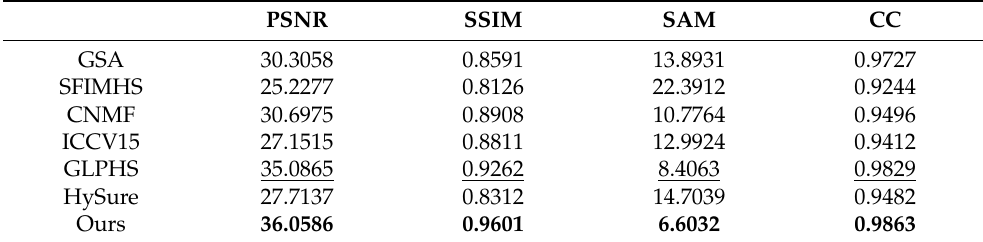
Figure 8. Results of CAVE dataset with real multispectral images. ( a ) results of GSA; ( b ) results of SFIMHS; ( c ) results of GLPHS; ( d ) results of CNMF; ( e ) results of ICCV15; ( f ) results of HySure; ( g ) ours results; ( h ) Ground truth. Table 4. Quantitative evaluation results of CAVE dataset with real multispectral